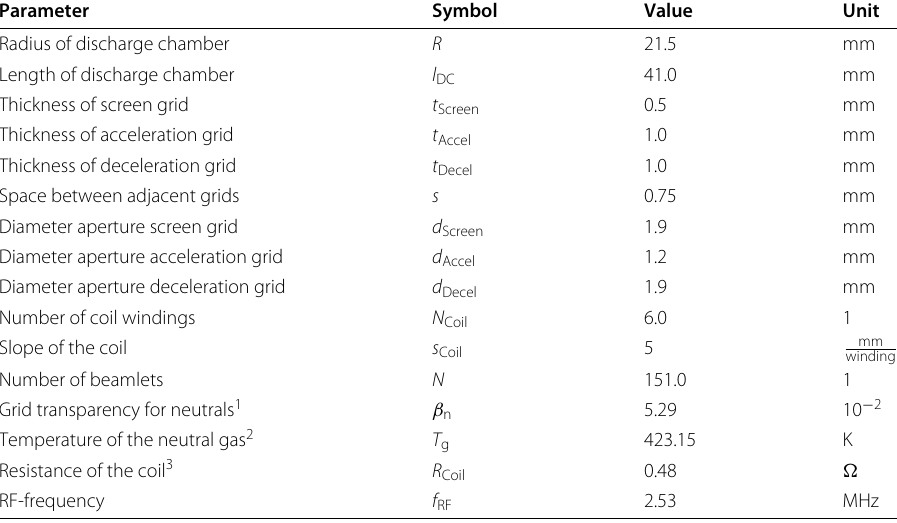
Table 2 Design parameters of the RIT4 and further input parameters of the global models Parameter Symbol Value Radius of discharge